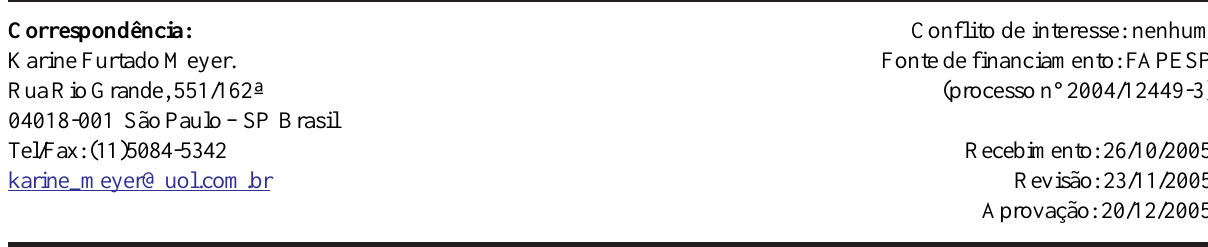
*Figuras coloridas disponíveis em